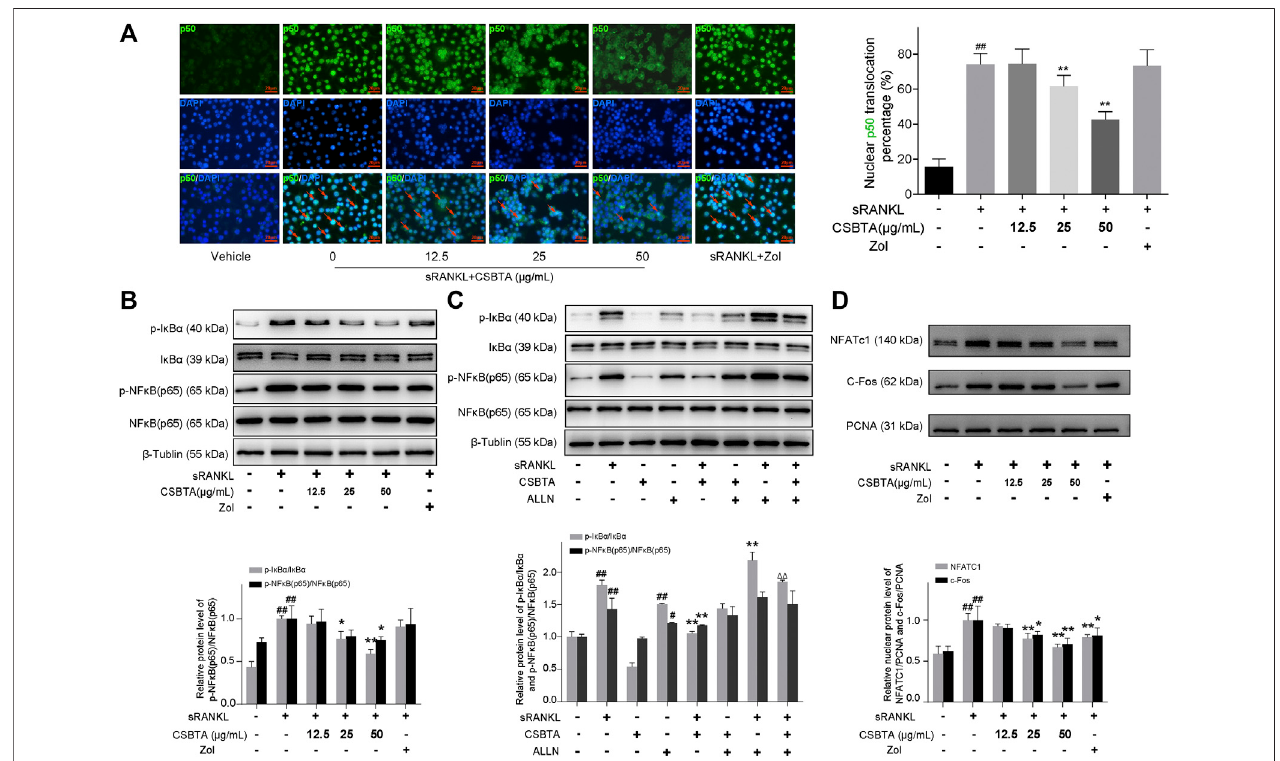
FIGURE 7 | CSBTA suppressed RANKL-induced NF- κ B activation and c-Fos/NFATc1 pathways in osteoclastogenesis. (A) RAW264.7 cells were double- stained for NF- κ B (p50) in green, and DAPIin blue to detect theNF- κ B (p50) localization after treatment with CSBTA. Scale bar (cid:2) 20 μ m. (B) RAW 264.7 cells were pretreated with CSBTA and followed by stimulation of sRANKL for 12 h to detect p-I κ B α and p-NF- κ B (p65) expression via Western-Blot. (C) RAW 264.7 cells were incubated with 50 μ g/ml ALLN, CSBTA (50 μ g/ml), sRANKL (10 nM) or the indicated combinations for 12 h to detect p-I κ B α and p-NF- κ B (p65) expression via Western-Blot. (D) RAW264.7 cells were pretreated with CSBTA and followed by stimulation with RANKL for 12 h to detect nuclear NFATc1, c-Fos expressionsbyWesternBlot.Thehistogramrepresentedfoldchangesofproteins.Allexperimentswererepeated for3times.Datawasexpressedasmeans ± SD and analyzed by one-way ANOVA. # p < 0.05, ## p < 0.01 sRANKL or ALLN vs. Vehicle, * p < 0.05, ** p < 0.01 sRANKL/CSBTA or ALLN/CSBTA or sRANKL/ALLN vs. sRANKL, ΔΔ p < 0.01, sRANKL/CSBTA/ALLN vs.